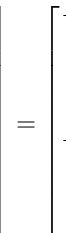
Table 1. Thermophysical properties of hybrid nanofluid [51].